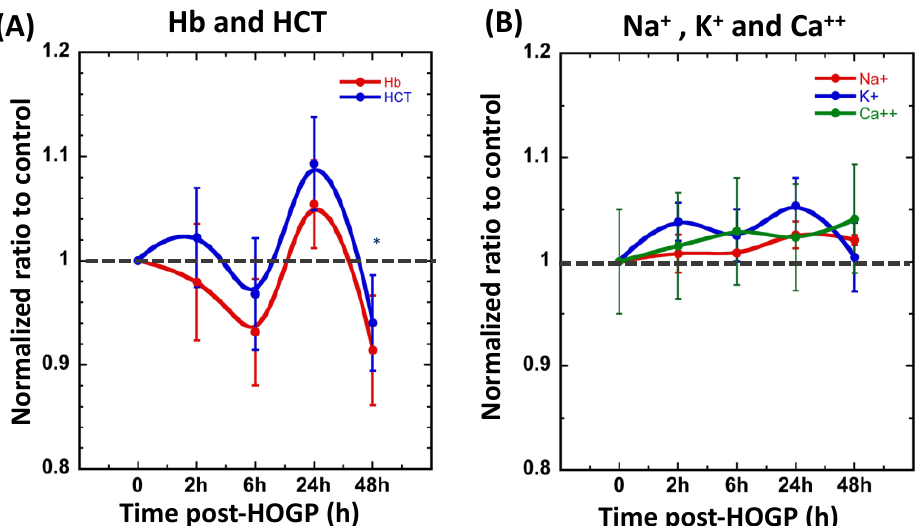
Figure 6. Normalized hematological ratios and electrolyte parameters post-application of the HOGP. Normalized Hb and HCT ratio ( A ), and the levels of Na + , K + and Ca ++ ( B ). The normalized ratios ( y -axis) were determined after normalization to the control group. Significant differences were identified using t -tests (* p < 0.05).